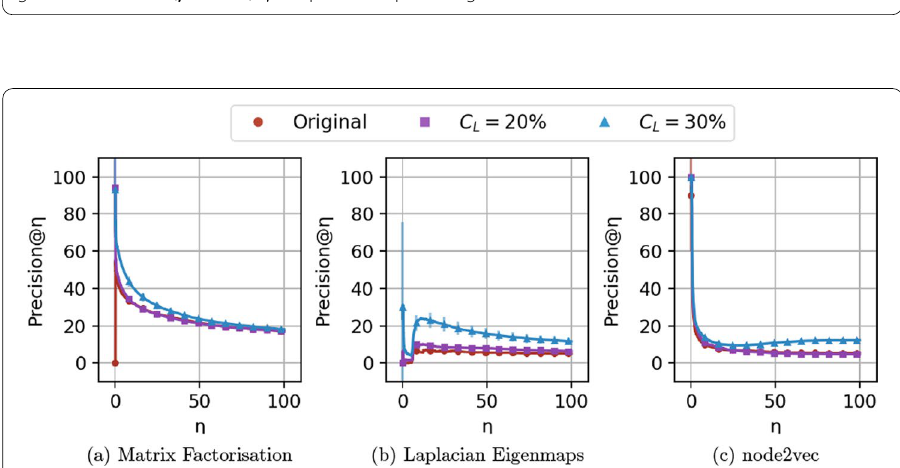
Fig. 10 Precision @ η obtained for network reconstruction, in average, applying each method to each version of the Hamsterster data set (original and rewired). η is expressed in